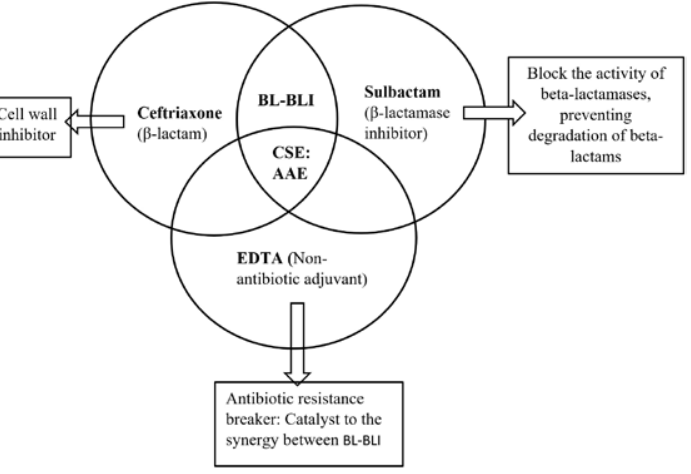
Fig. 1. The mechanism of action of CSE Note: CSE: Ceftriaxone+Sulbactam+EDTA, BL-BLI: beta lactam-beta lactamase inhibitor, AAE: antibiotic adjuvant entity, EDTA: ethylene-diamine-tetraacetic